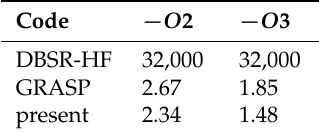
Table 6. Performance comparison of the average computer time ( µ s ) required for calculating a